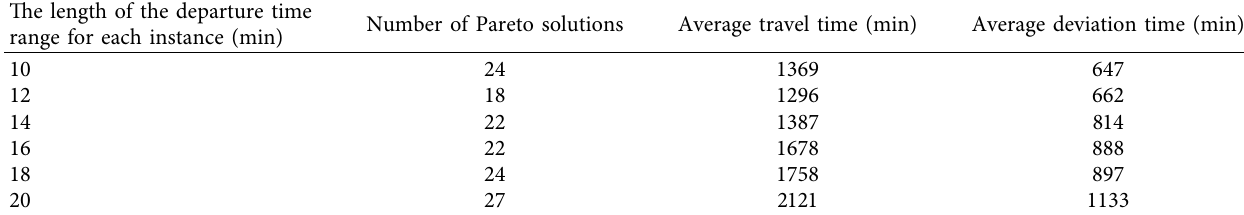
Table 14: Analysis of the different departure time ranges of the first trains at starting stations. The length of the departure time range for each instance (min)